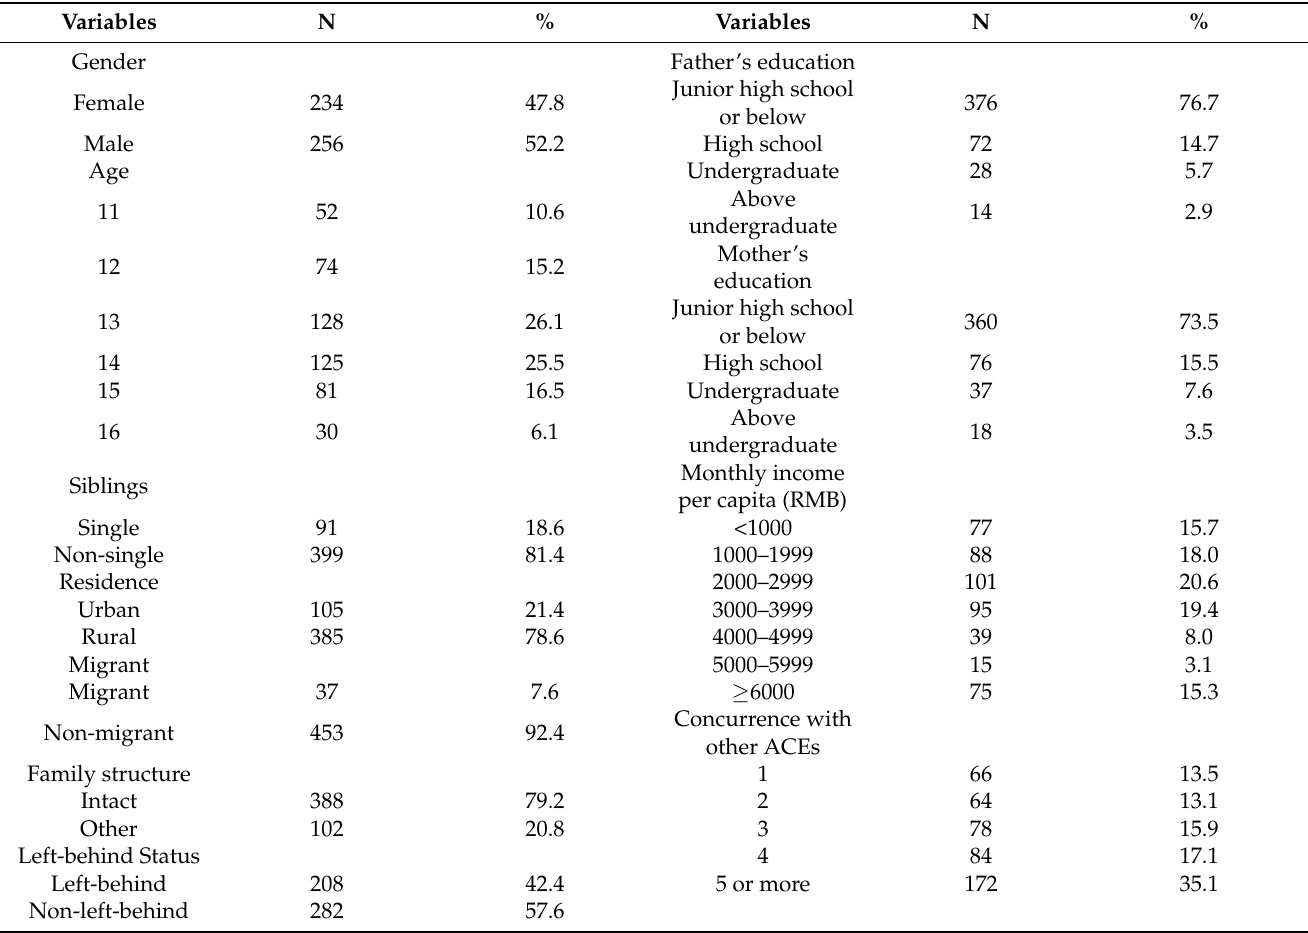
Table 1. Demographic characteristics of the study participants (N =